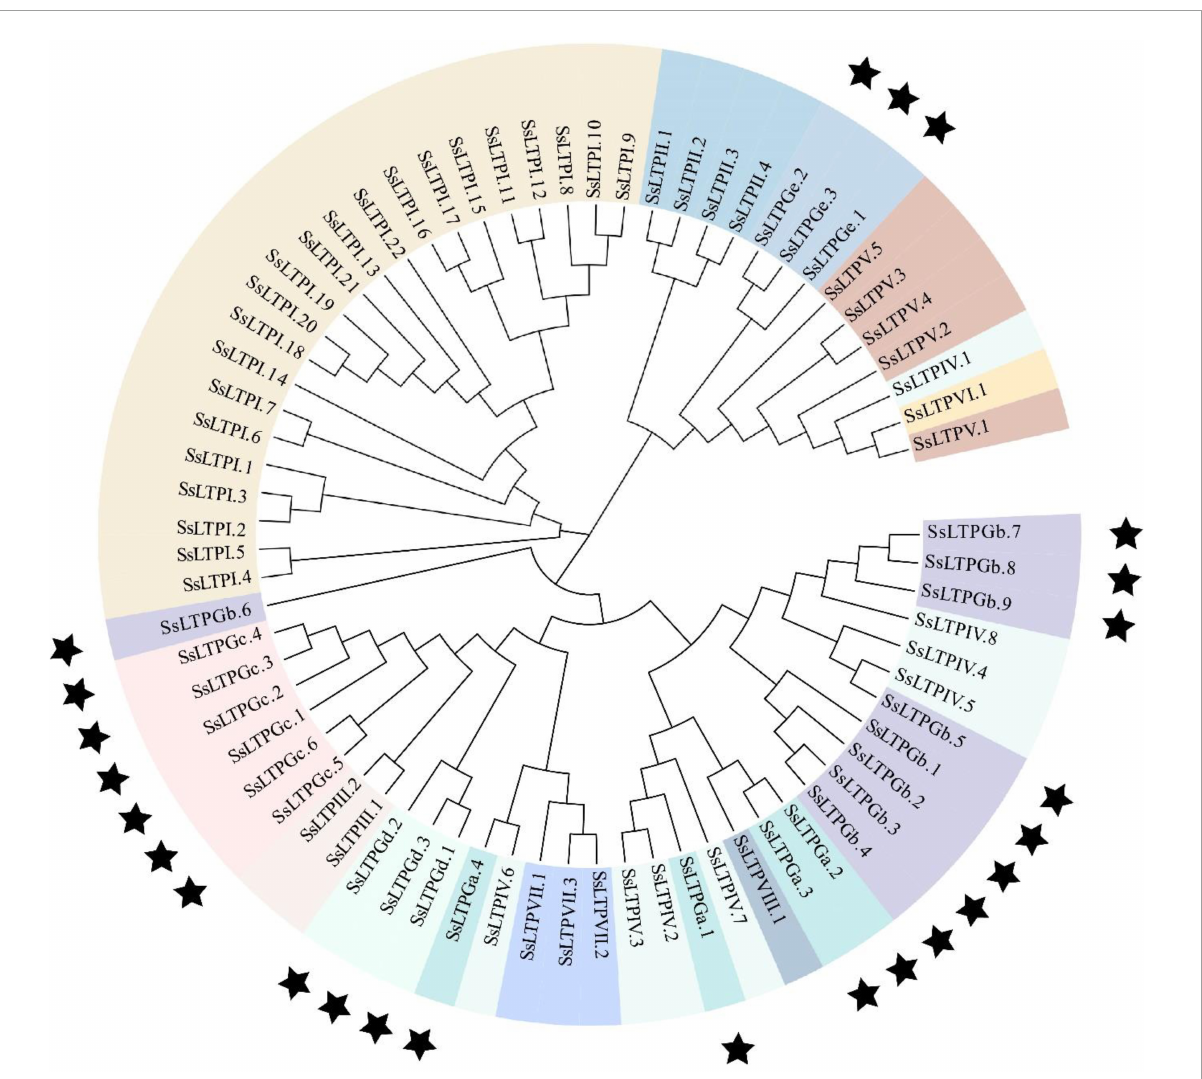
FIGURE2 Phylogenetic tree of 71 SsnsLTP genes identified in S. spontaneum . The tree was constructed using the neighbor-joining (NJ) method with 1,000 bootstrap replicates. Genes shaded with the same color are the same type and black stars indicate G groups having a GPI gene.